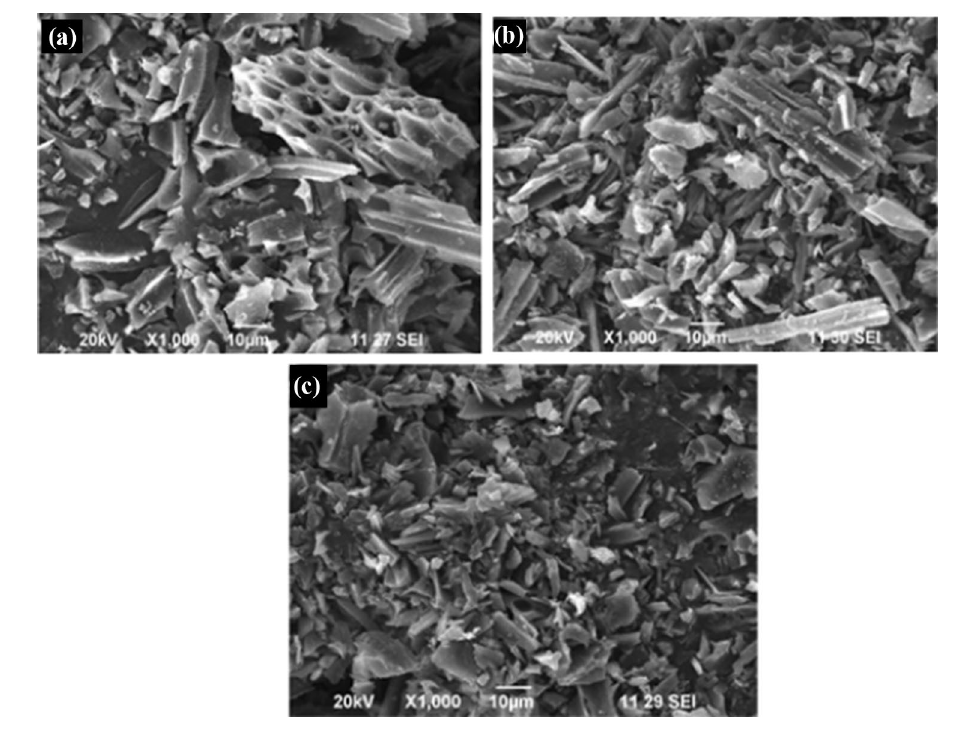
Fig. 8 SEM images of a pure